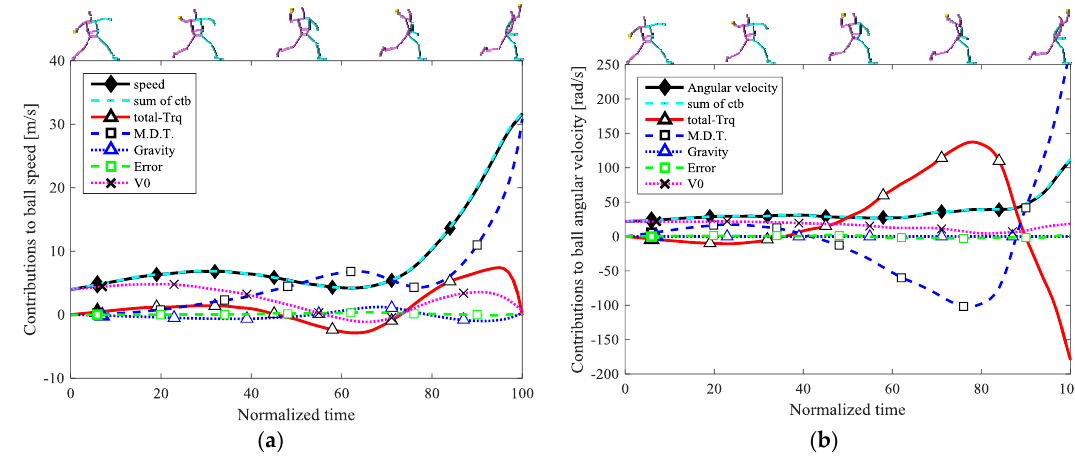
Figure 3. Contributions of individual terms to the ball variables with respect to the 16-segment model: ( a ) contributions to the ball speed; ( b ) contributions to the ball angular velocity.